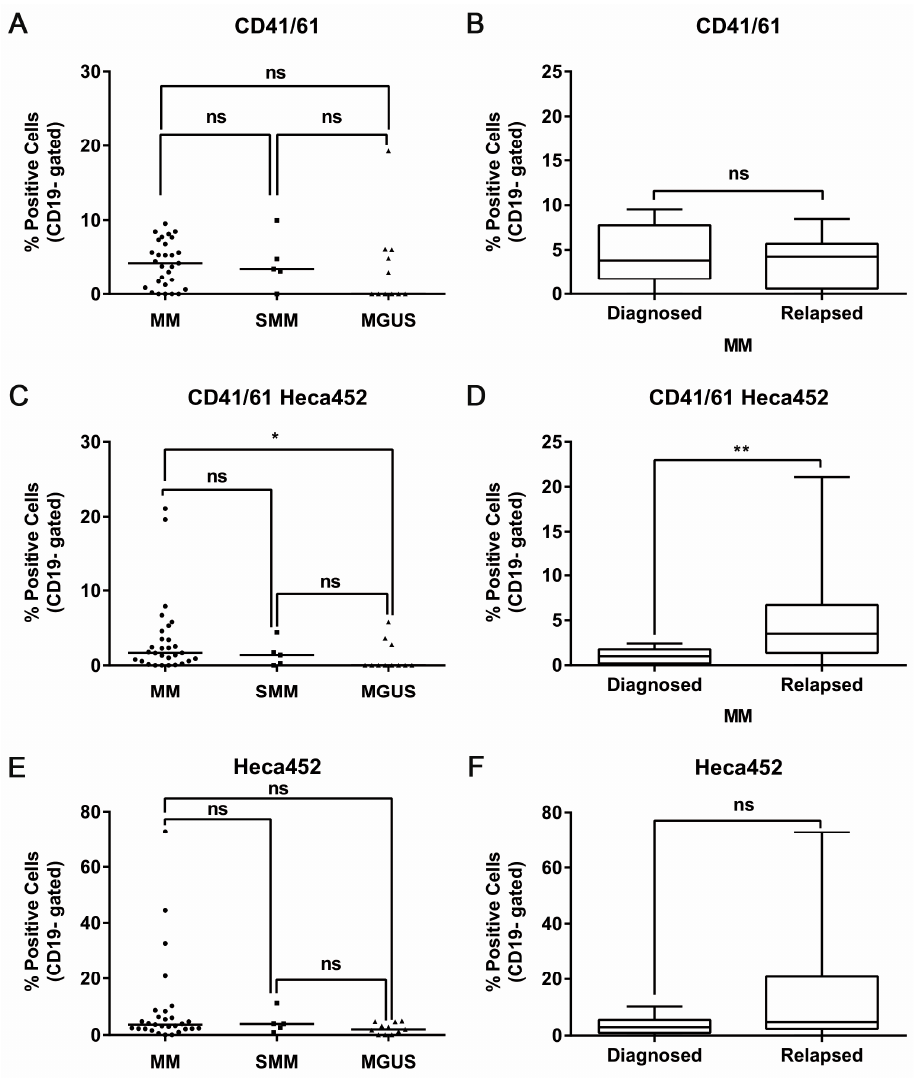
Figure 5. Platelets bind SLe a/x -enriched primary MM cells in BM samples of MM patients with significant enrichment in the symptomatic disease stage and at relapse. BM specimens were collected from MM patients in citrate, lysed in ammonium chloride-based buffer and stained for flow cytometry. Malignant plasma cells were defined as CD38+, CD138+, CD2-, CD14- and CD19- cells. Distribution of the CD41/61- ( A ), the CD41/61-HECA452 double positive ( C ) and the HECA452-positive ( E ) population at different disease stages. Horizontal lines represent the median. Box and whiskers showing the distribution of the CD41/61- ( B ), the CD41/61-HECA452 double positive ( D ) and the HECA452-positive ( F ) population in diagnosed versus relapsed MM patients. Statistical analysis was performed using either the two-way ANOVA and Sidak’s multiple comparison tests ( A , C , E ) or the non-parametric Mann-Whitney test ( B , D , F ). ** p <0.01; * p < 0.05; ns non-significant.